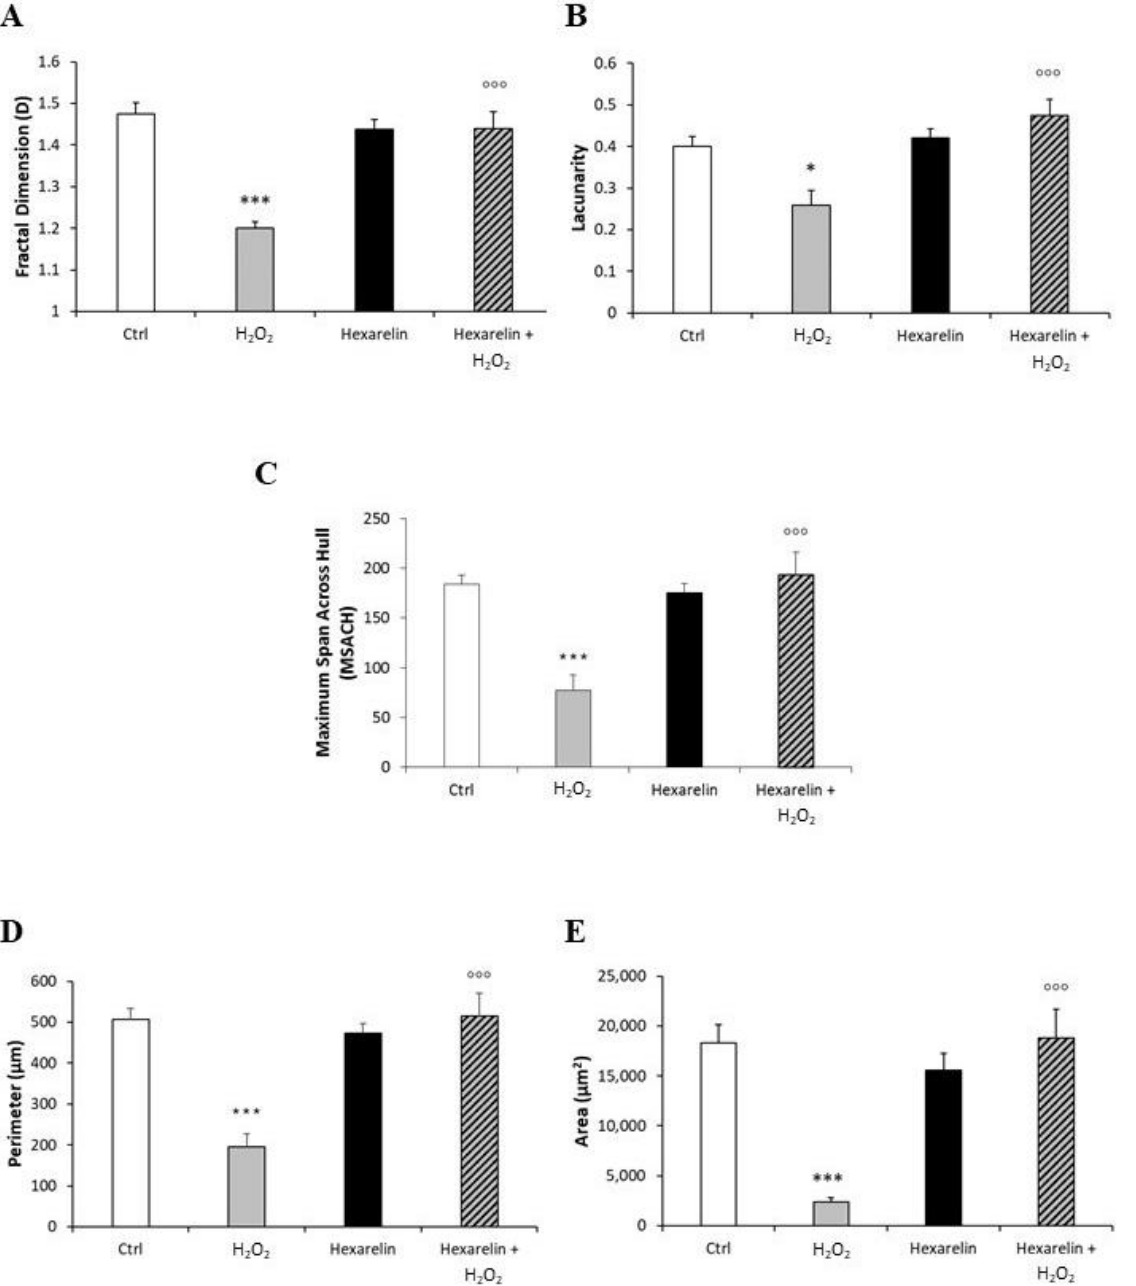
Figure 6. Hexarelin modulates morphological changes of Neuro-2A cells induced by H 2 O 2 treatment. ( A ) Fractal dimension, ( B ) lacunarity, ( C ) maximum span across hull, ( D ) perimeter, and ( E ) area graphical representation of Neuro-2A cells treated for 24 h with or without hexarelin and 100 µM H 2 O 2 . Total number of cells analyzed for each condition=10. Data are expressed as mean ± SEM. Statistical significance: * p < 0.05, *** p < 0.001 vs. CTRL; °°° p < 0.001 vs. H 2 O 2 .